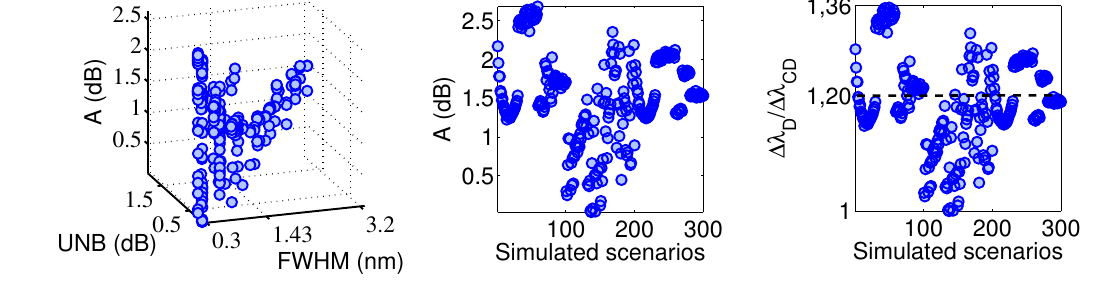
as a function of the simulated ∆ λ CD